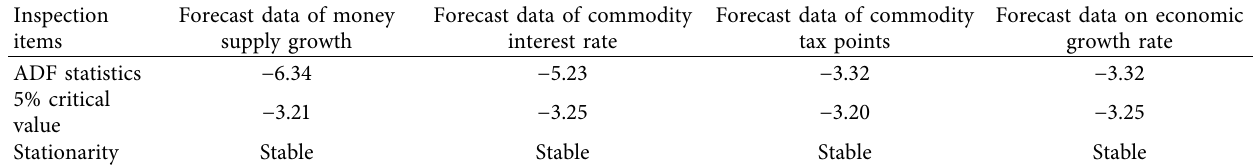
Table 7: Test results of time series